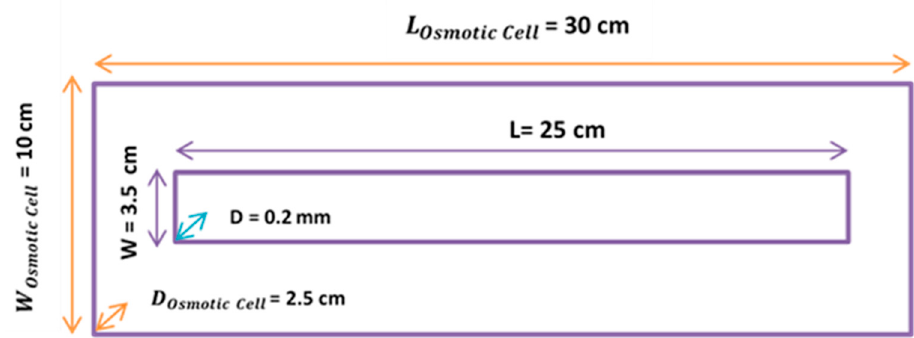
Figure 4. Osmotic cell dimensions